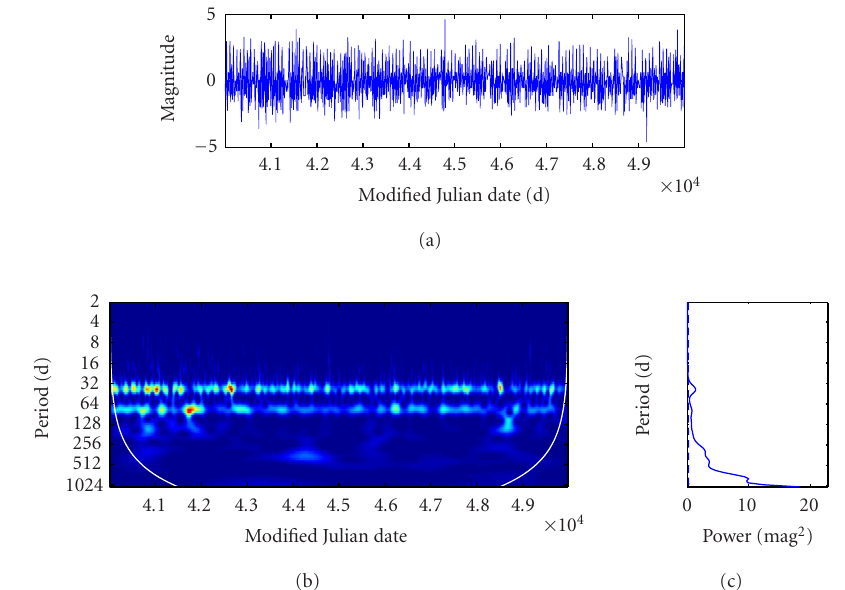
Figure 7: (a) AC Herculis light curve. (b) Wavelet power spectrum. The continuous white line indicates the cone of influence. (c) Global wavelet spectrum of the simulated signal with a Morlet wavelet. The 95% confidence level that could be obtained for a white noise is shown by the dashed line.